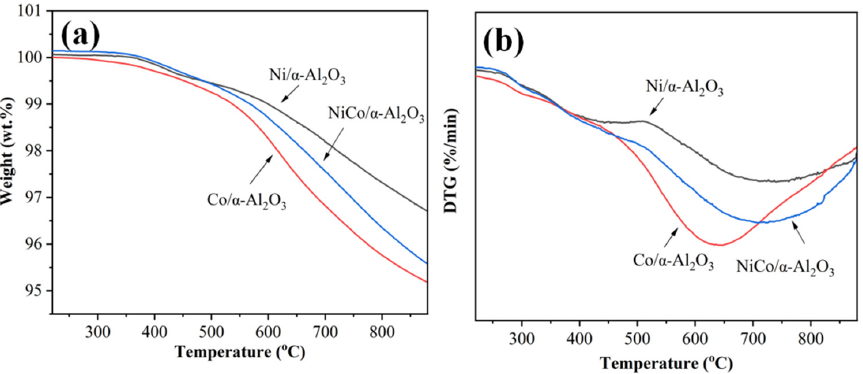
Figure 5. TG ( a ) and DTG ( b ) curves of fresh catalysts with respect to temperature programmed reduction at a heating rate of 10 K·min –1 in 5 vol.% H 2 in Ar.